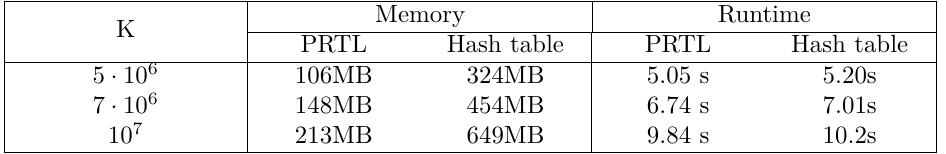
Table 4: Comparing the insertion runtime and memory occupation of a PRTL vs. a hash table. K